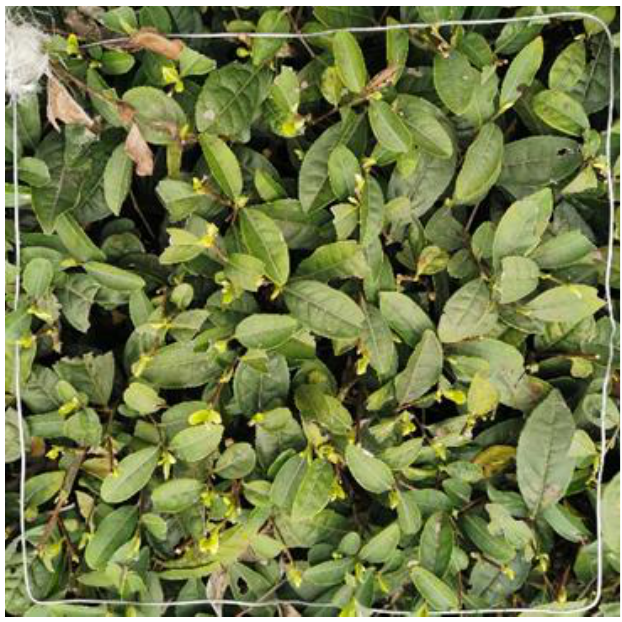
Figure 2. Fuding white tea trees.